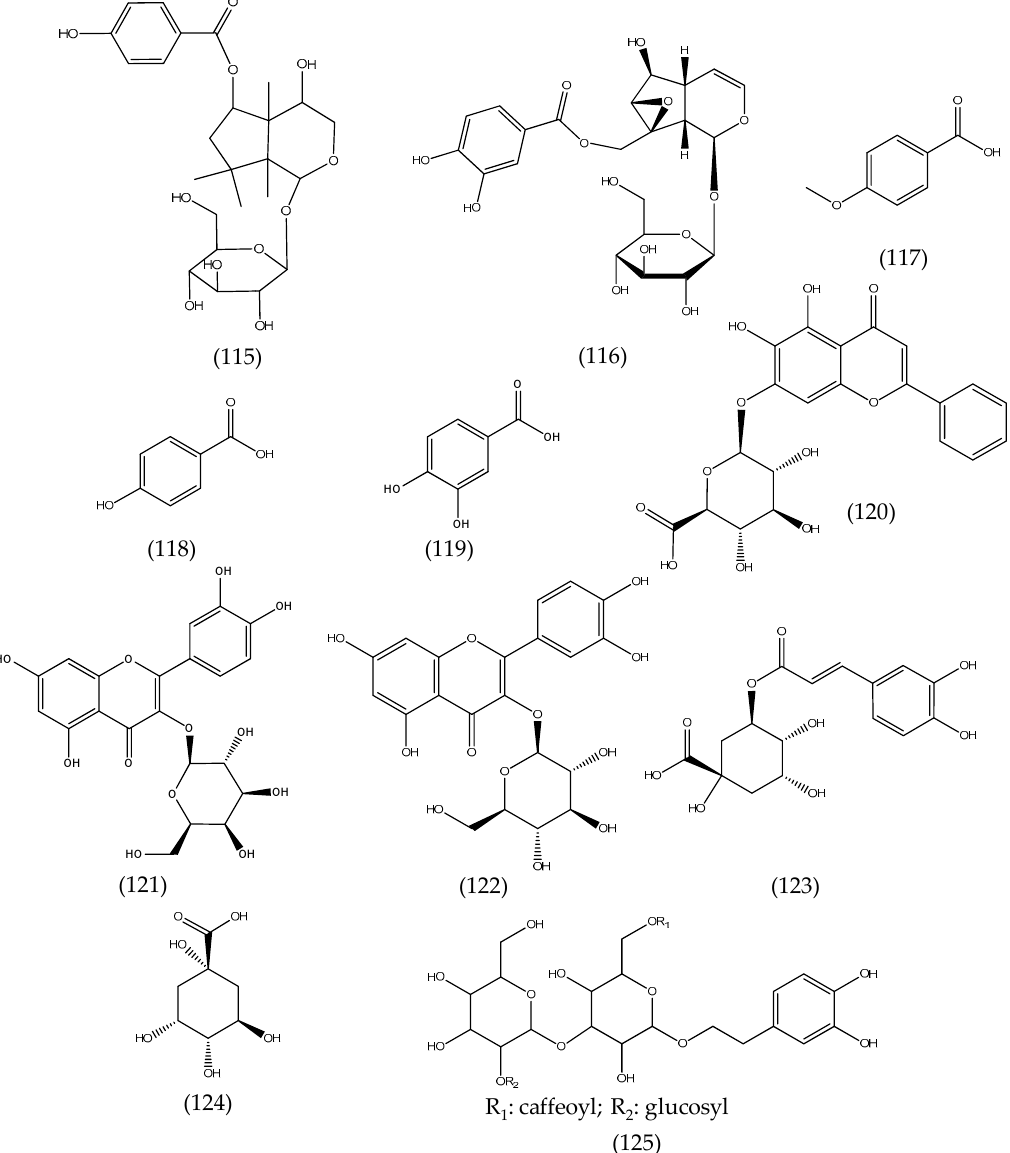
Figure 17. Structures of compounds reported in several Veronica species: Veronica americana , Veronica jacquinii , Veronica teucrium , and Veronica urticifolia .